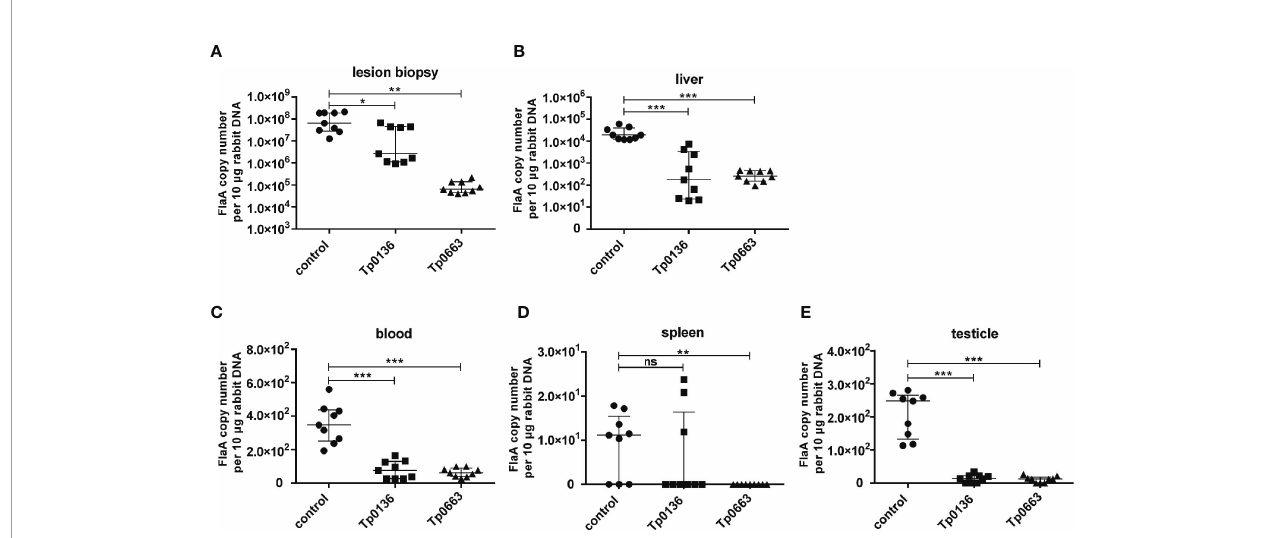
FIGURE 4 | Immunization with Tp0136 or Tp0663 inhibited T. pallidum dissemination. Spirochete numbers were evaluated in control, Tp0136-immunized, or Tp0663-immunized animals by using qPCR to measure fl aA DNA concentrations in lesion biopsies. The bacterial burdens in lesion biopsies are shown (A) at the local infection site, as well as in the disseminated infection sites of the (B) liver, (C) blood, (D) spleen, and (E) testicles at day 21 post-infection. Results were normalized within each tissue type based on the concentration of rabbit genomic DNA and presented as median ± interquartile range. Signi fi cance was assessed using Students t test (ns, not signi fi cant; P > 0.05,* P < 0.05, ** P < 0.01, *** P < 0.001). Points correspond to three separately extracted tissue samples from each rabbit organ (nine total points in each group) were analyzed for reproducibility.